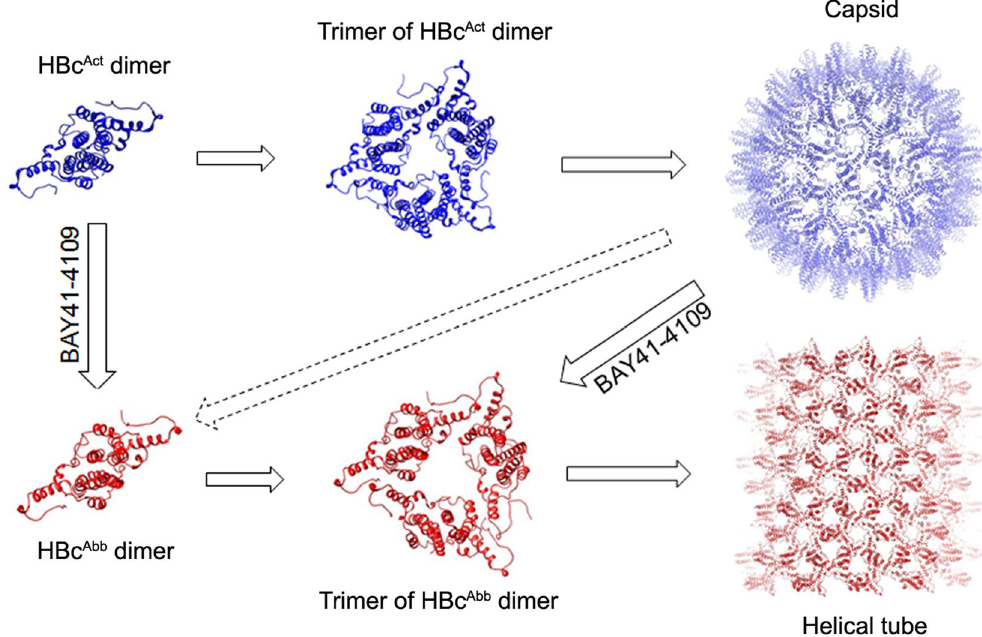
Figure 6. Schematic model of HBc assembly controlled by allosteric conformational changes. In wild-type, the HBc dimer is in the assembly-active (HBc Act ) conformation and the HBc dimers first assemble into trimer of dimers, in which the interactions between dimers are weak, hence the trimer is thermodynamically unstable therefore the assembly proceeds further to a large, closed ensemble, the capsid (upper panel). BAY41-4109 induces a conformational change of HBc dimer and renders it into an aberrant conformation (HBc Abb ), the HBc dimers first assemble into trimer of dimers, in which the interactions between dimers are even weaker, hence the trimer is thermodynamically unstable therefore the assembly proceeds further to an even large ensemble, the tube (lower panel). The binding of BAY41-4109 to the preformed capsid can also change the conformation of HBc dimer from HBc Act to HBc Abb and destabilize the capsid, which may render the capsid to dissociate into trimers of dimers or dimers; the trimers of dimers or dimers then re-associate to assemble into a